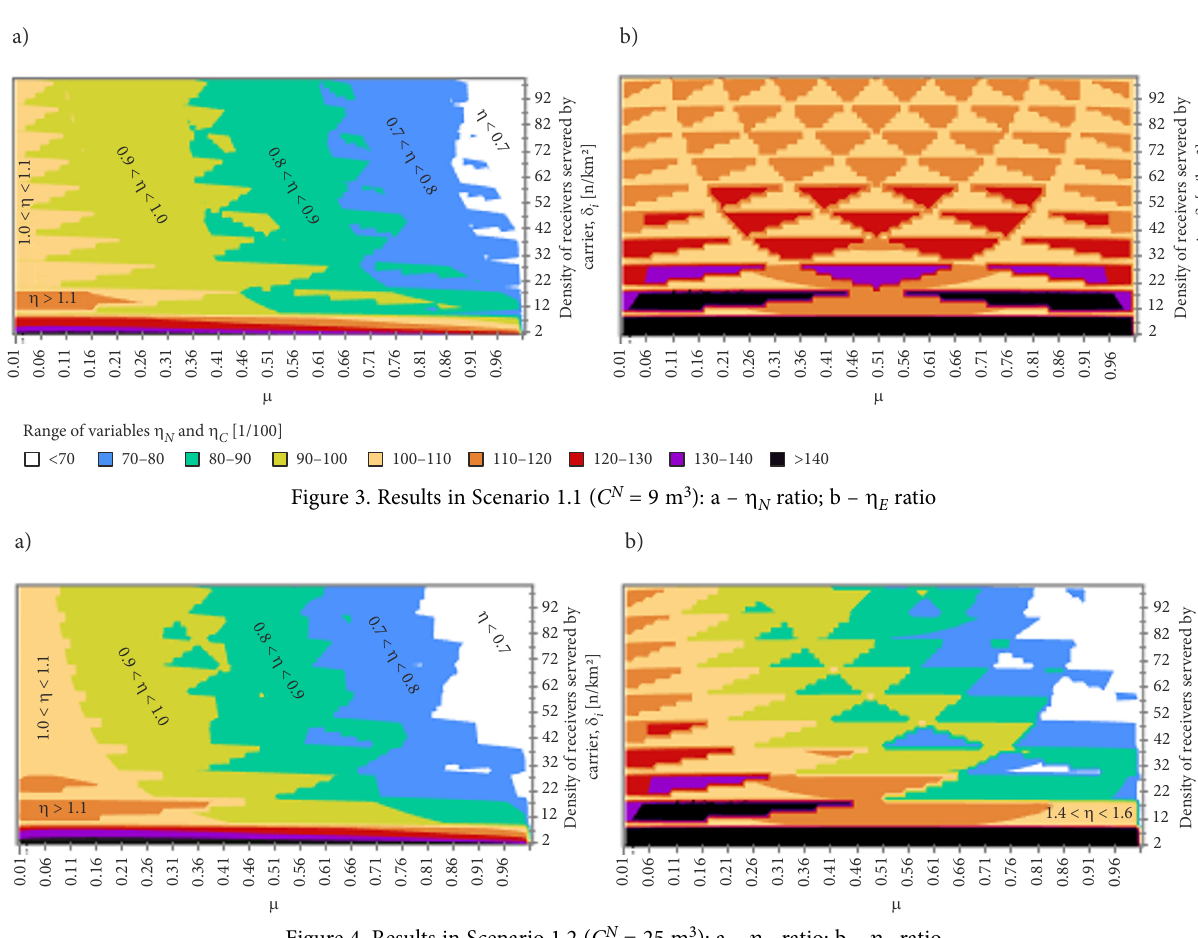
Figure 4. Results in Scenario 1.2 ( C N = 25 m 3 ): a – h N ratio; b – h E